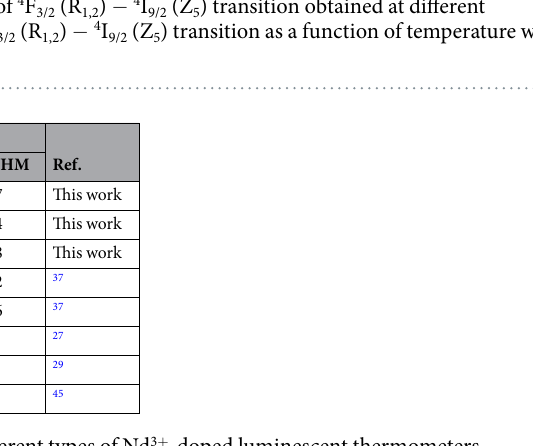
Table 1. Comparison of sensitivities for different types of Nd 3 + -doped luminescent